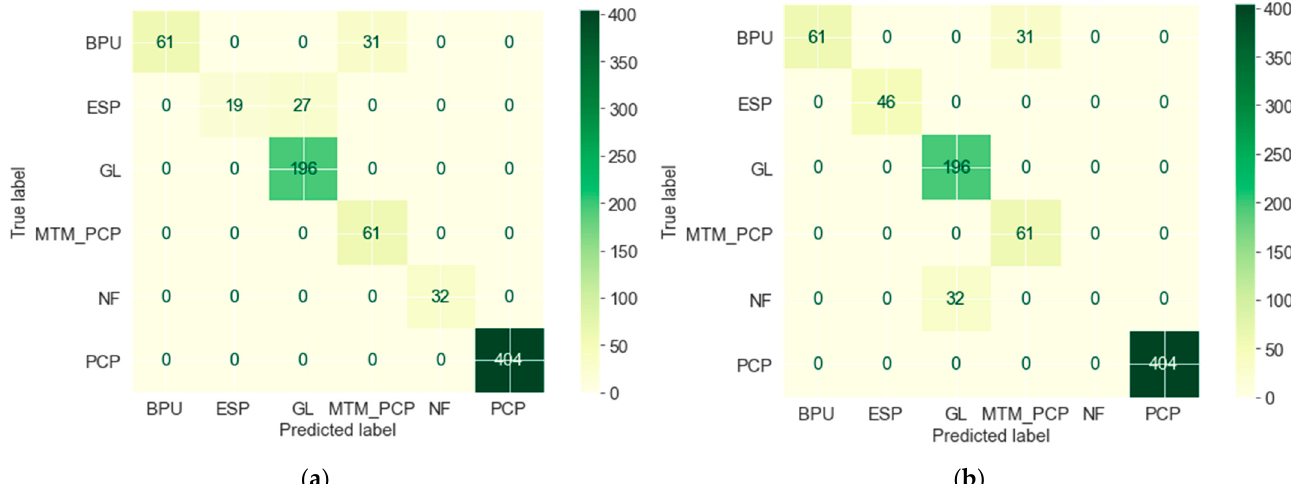
Figure 5. Model training error vs. test prediction error. ( a ) DT prediction error; ( b ) RF prediction error.